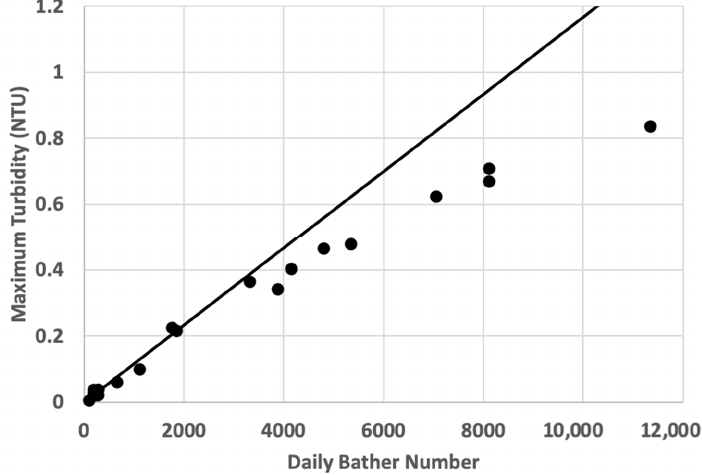
Figure 5. Empirical relationship between daily bathing load and the measured peak turbidity (NTU) over a wide range of daily bather numbers, based on the 21 consecutive days of data presented